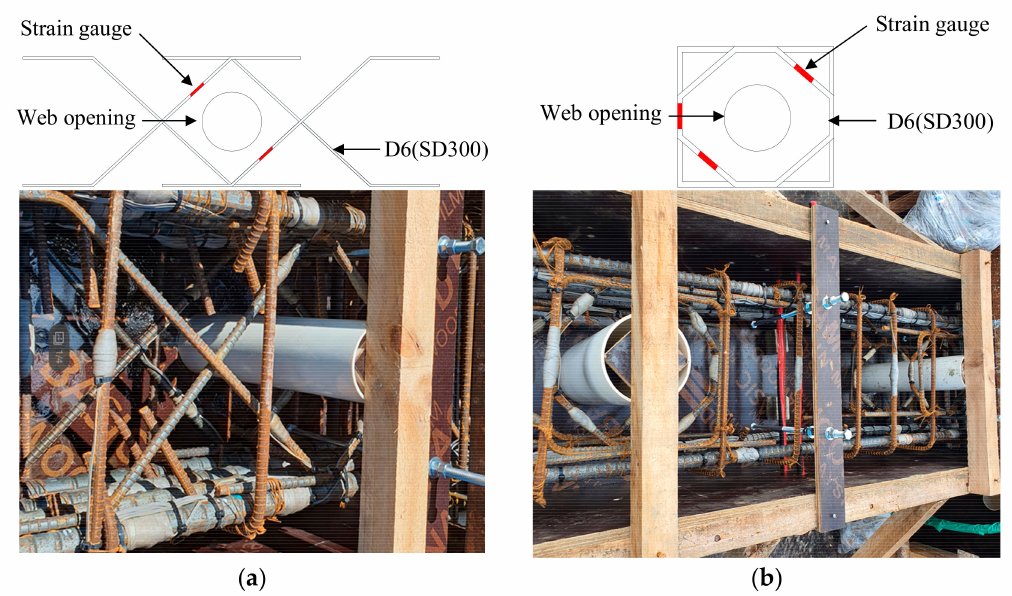
Figure 1. Details of web opening reinforcements: ( a ) Type A; ( b ) Type